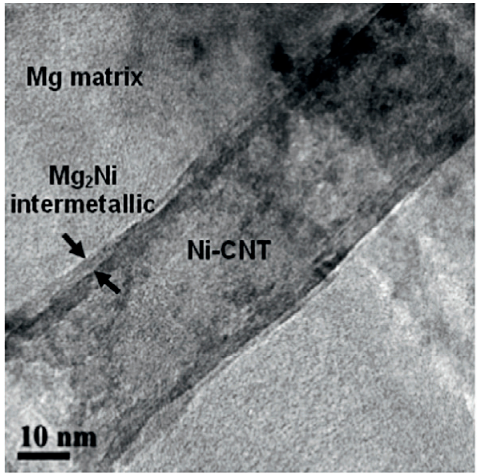
Figure 21. TEM image of (Ni-coated MWNT)-Mg composites, showing the presence of Mg 2 Ni